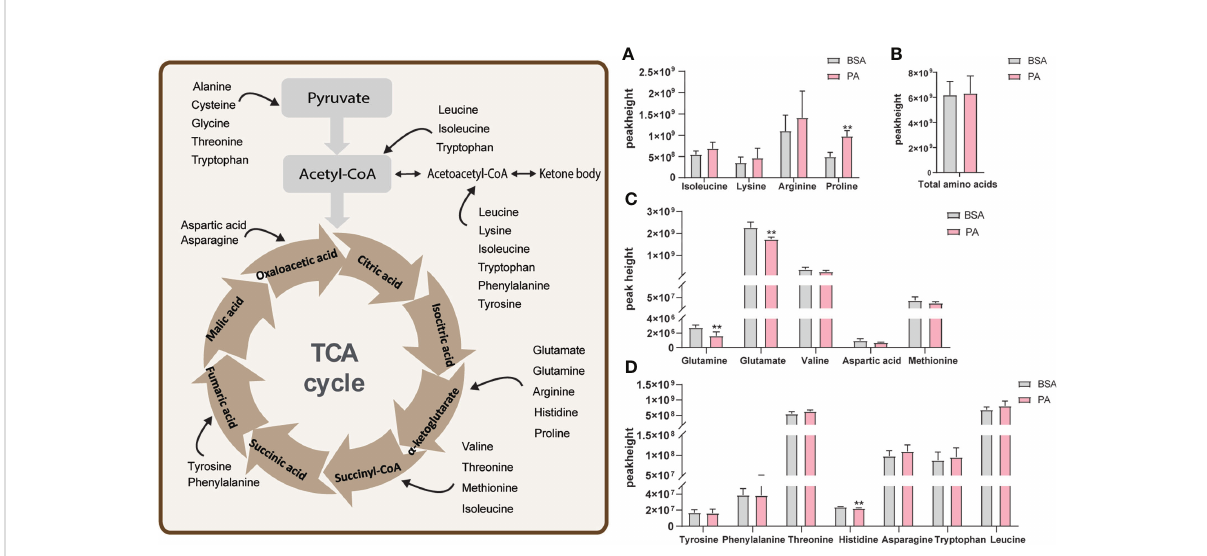
FIGURE 4 Effect of PA on amino acid metabolism of SCs. The schematic diagram of amino acids participating in the TCA cycle is shown on the left. Amino acids enter the TCA cycle through conversion into different substances. Peak height of amino acids that participate in the TCA cycle (A, C, D) and the total amount of these amino acids (B) . Data were expressed as mean ± SD, **p < 0.01.